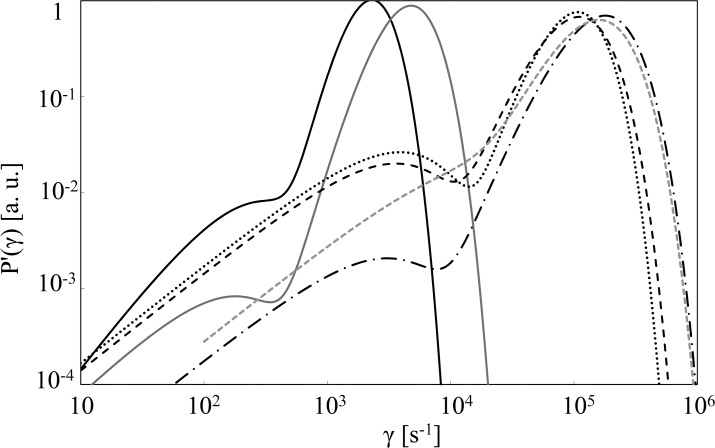
Rate distribution functions for DL decays.Rate distribution functions for DL decays from samples at different glycerol mole fraction xg: (black solid line) xg = 1.00, (grey solid line) xg = 0.80, (dash-dotted line) xg = 0.26, (dashed line) xg = 0.09, (dotted line) xg = 0.03, (grey dashed line) xg = 0.00 (water). T = 20°C.